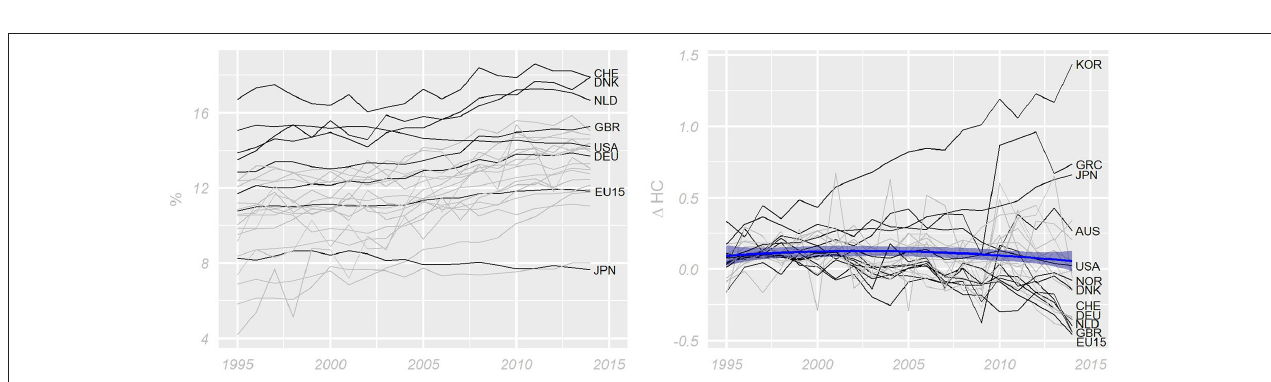
FIGURE 6 | Ratio of counterfactual and factual MNCS per country (gray points), annual mean ratio (black point) and linear extrapolation.